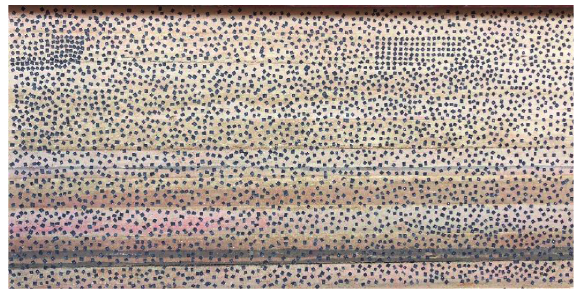
Figure 10: Speckle layout.